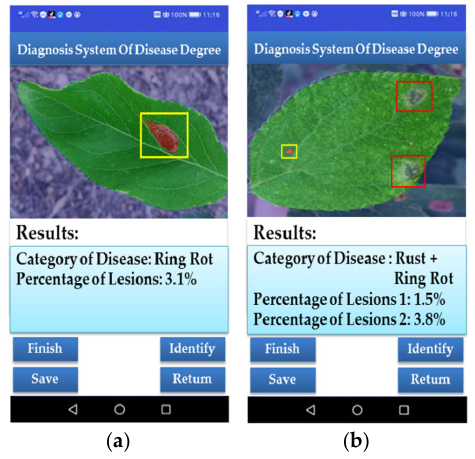
Figure 12 . The results of APP program recognition: ( a ) the result of a single disease per leaf; ( b ) the result of multiple diseases per leaf.